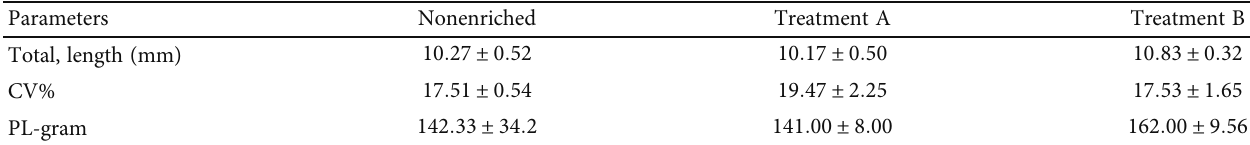
Table 4: Total length (mm), coe ffi cient of variation of population sizes (%), and number of postlarvae in a gram weight of P. vannamei (PL12) ( mean ± SD, n = 3